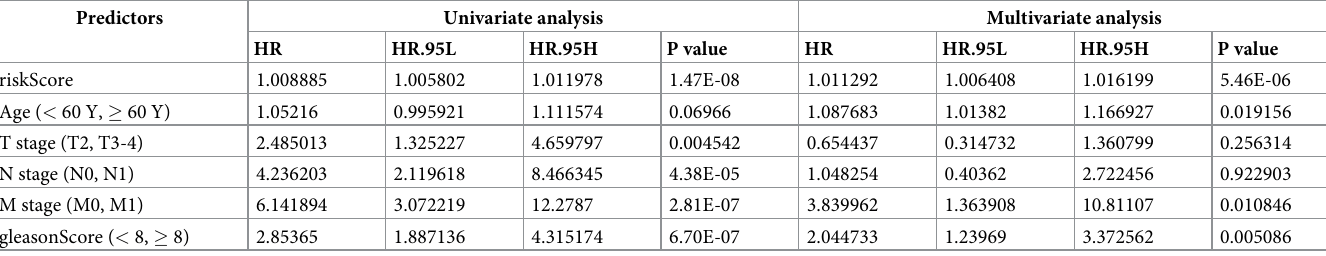
Table 5. ICGC OS-related univariate as well as multivariate Cox regression